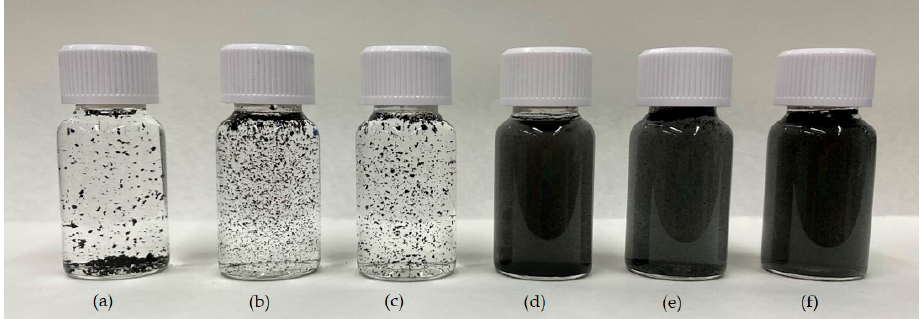
Figure 5. Hydrophilic behavior of ( a ) as-received, ( b ) cryo-ground, ( c ) H 2 O 2 -modified, ( d ) H 2 SO 4 -modified, ( e ) HNO 3 -modified, and ( f ) H 2 SO 4 /HNO 3 -modified GTR.